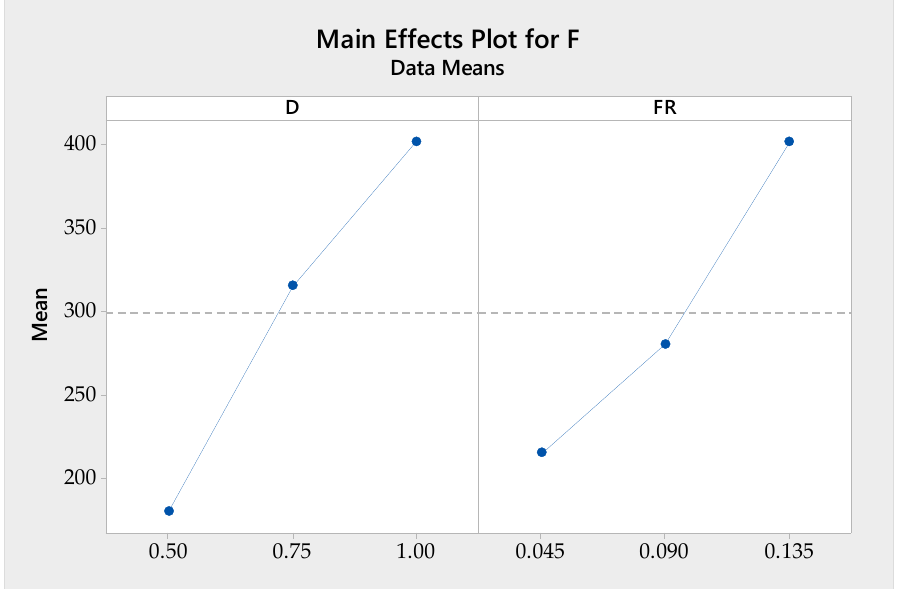
Figure 10. Main effect plots for F using conventional edge.